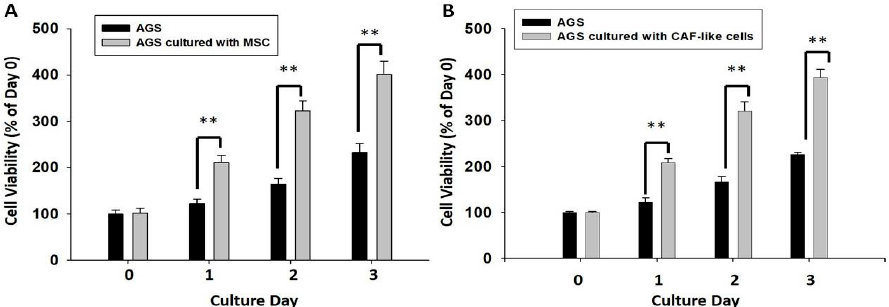
Figure 7. HBMMSCs ( A ) or CAF-like cells ( B ) enhance survival in human gastric cancer cells. HBMMSCs or CAF-like-cells were co-cultured with human AGS gastric cancer cells for various periods (1, 2, 3 days). The effect of HBMMSCs or CAF-like cells on cellular survival of human gastric cancer cells was measured. The responses to HBMMSCs or CAF-like cells were measured by MTT assay. ** p < 0.01 versus only AGS cells (mean ± SD, n = 3).